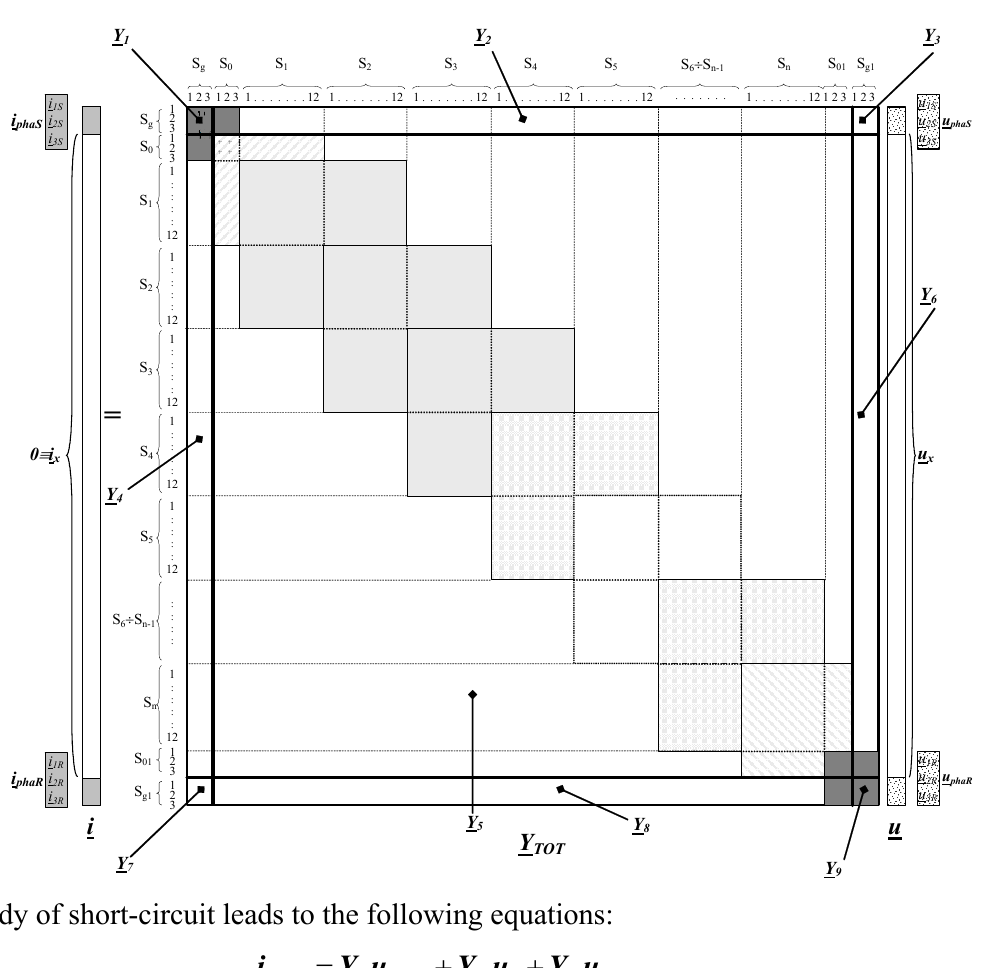
· u in short-circuit TOT